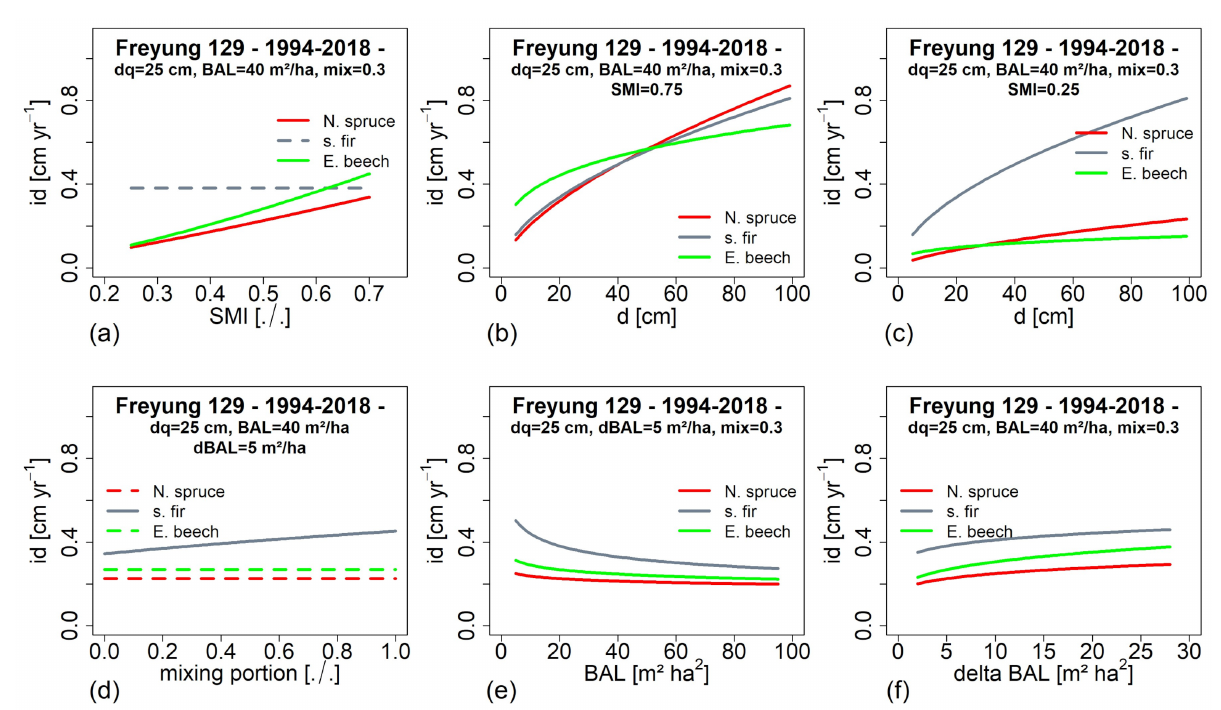
Figure 11. Stem diameter growth, id, of Norway spruce, silver fir, and European beech on the selection forest experiment Freyung 129 in the period with low atmospheric SO 2 -load (1993–2018). Visualized is the modification of id by ( a ) Soil Moisture Index, ( b ) stem diameter growth in wet periods, ( c ) stem diameter in dry periods, ( d ) mixing portion in the neighborhood, ( e ) local stand density, and ( f ) density reduction by selection cutting (according to Model 6b, see Table 4). Broken lines indicate non-significant, invariant